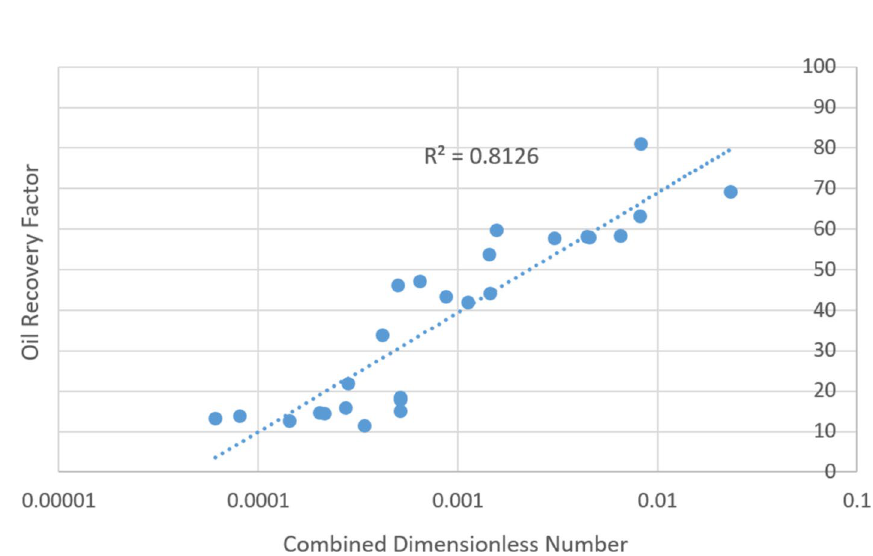
Fig. 6 Comparison of predicted oil recovery factor and experi- mental oil recovery